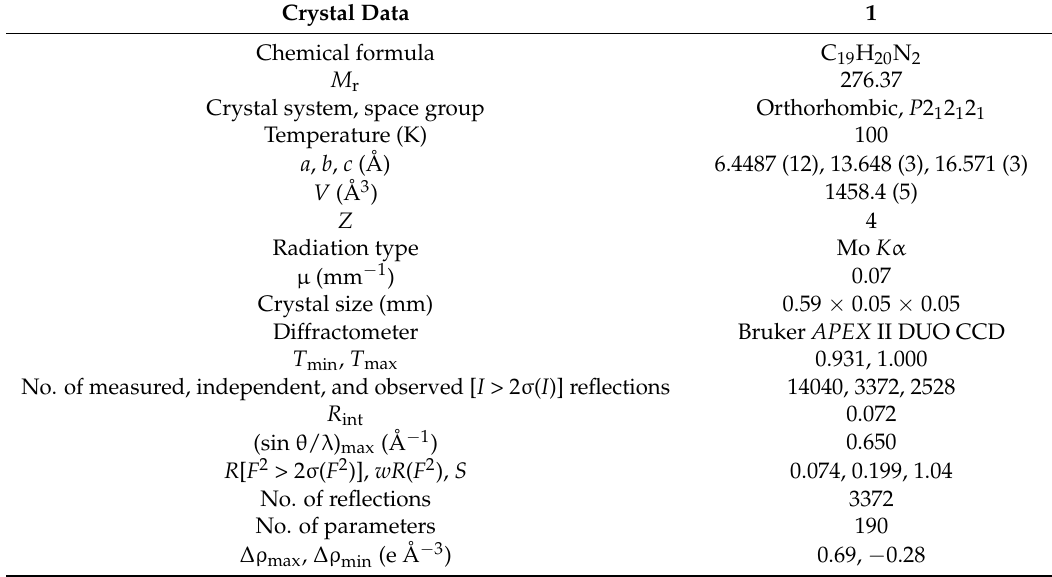
Table 2. Crystal data and refinement parameters of the tile compound 1